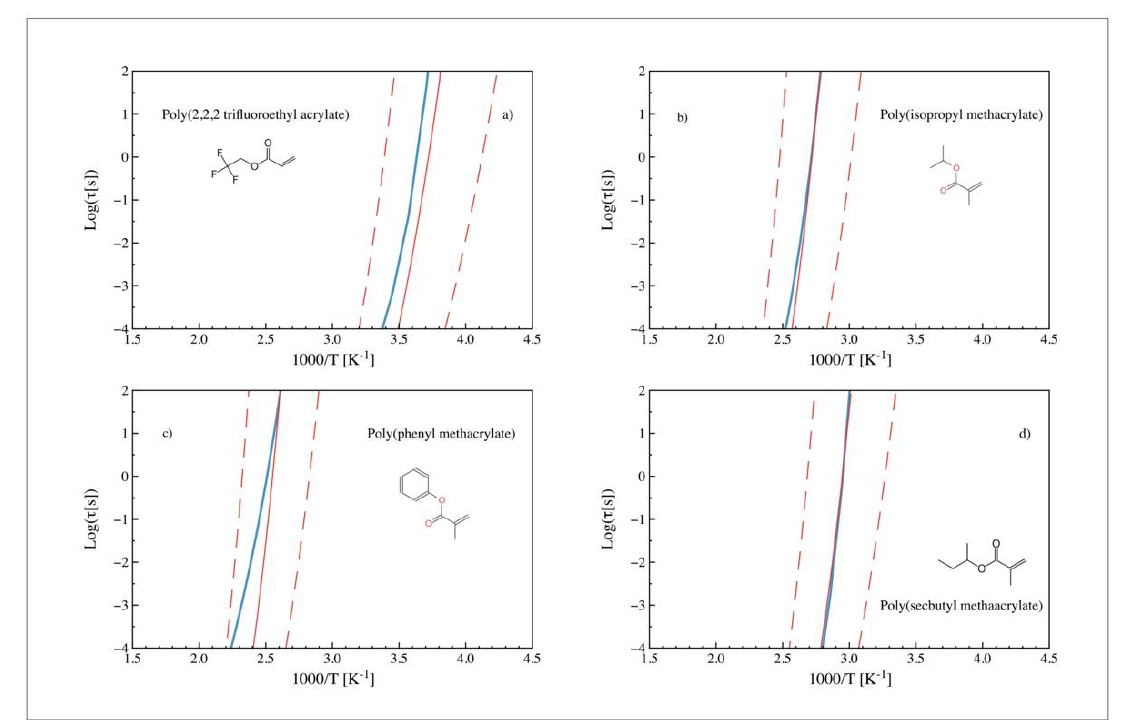
Figure 6. Experimental (blue) and predicted (red) relaxation times (obtained from ECNLE theory) vs. 1000/T after introducing the scaling parameter ( a ) for nonlinear tailed polymers. The corresponding monomeric chemical structure are also shown. ( a ) Poly (2, 2, 2 trifluoroethyl acrylate) [31], ( b ) poly (isopropyl methacrylate) [29], ( c ) poly (phenyl methacrylate), and ( d ) poly (secbutyl methacrylate) [30].